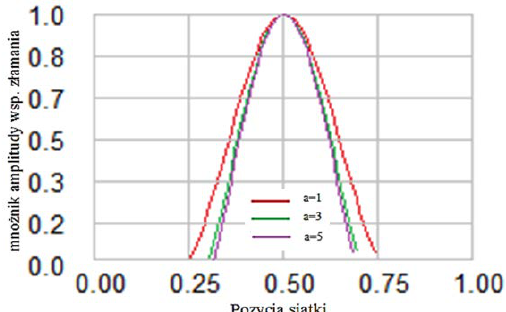
Fig. 14. Blackman apodization function for different values of the parameter a.